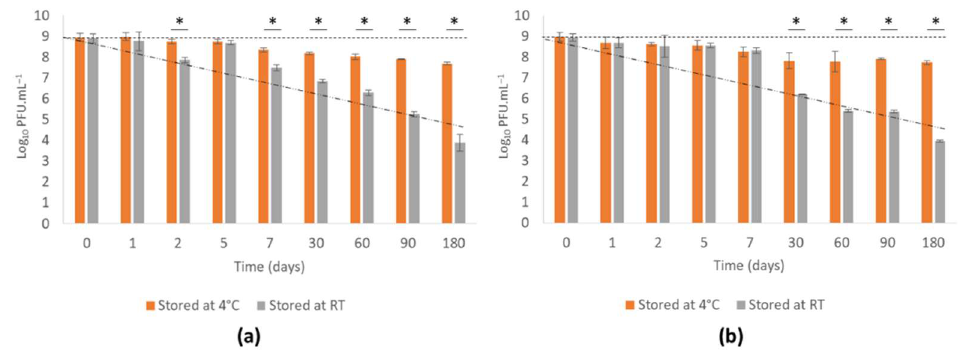
Figure 5. Stability of phage vB_PaeM-SMS29 in MNs after storage at 4 °C and room temperature (RT) for different periods up to 180 days. ( a ) BA MNs; ( b ) INL MNs. * statistically significant ( p < 0.05). The dashed black line and the long dashed line with dots correspond to the concentration of vB_PaeM-SMS29 stored at 4 °C and RT in SM buffer.